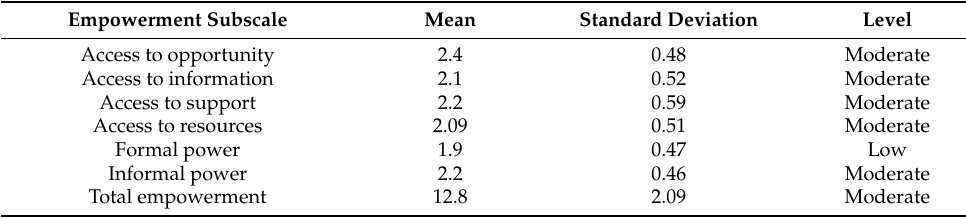
Table 2. The means and standard deviations of nurses’ empowerment